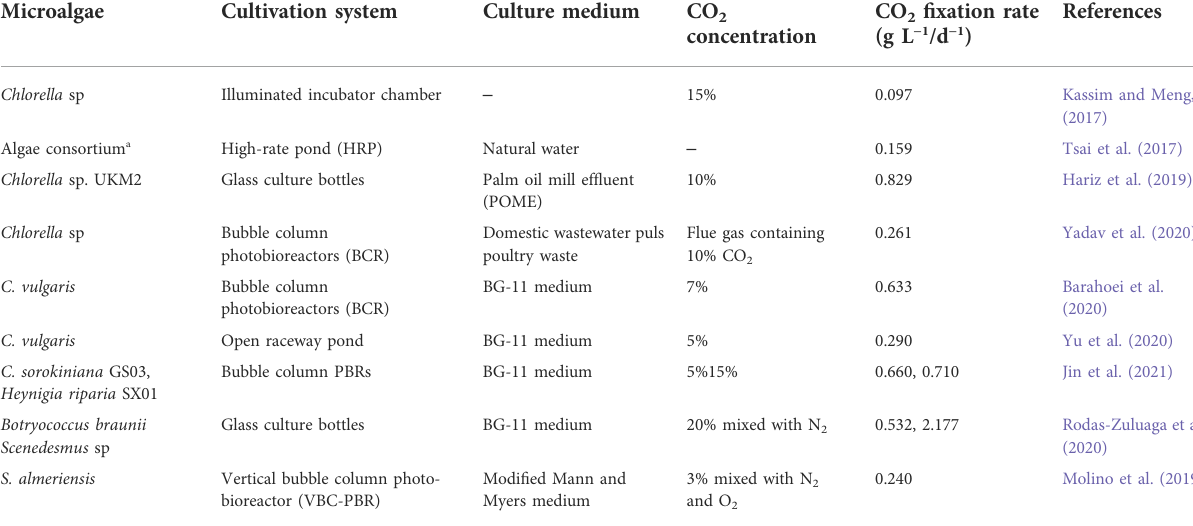
TABLE 4 CO 2 fi xation using various microalgae species under various cultivation systems.